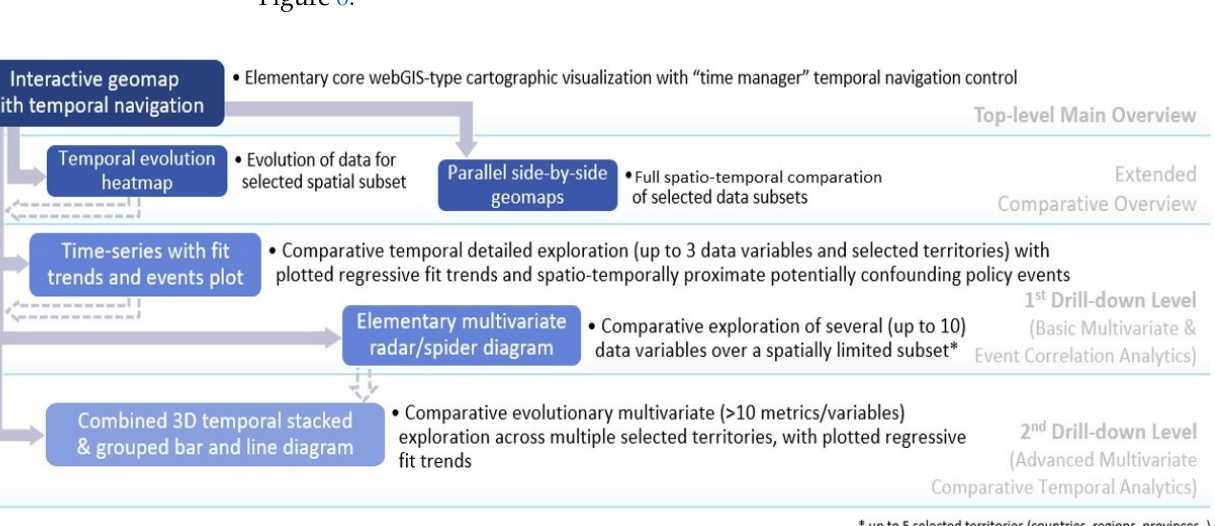
Figure 5. A sample page of the Atlas WebGIS with side-by-side visualization of two maps, one showing the number of deaths ( left side ) and the other showing the Business Rrestiction Index ( right side ) for the same week.